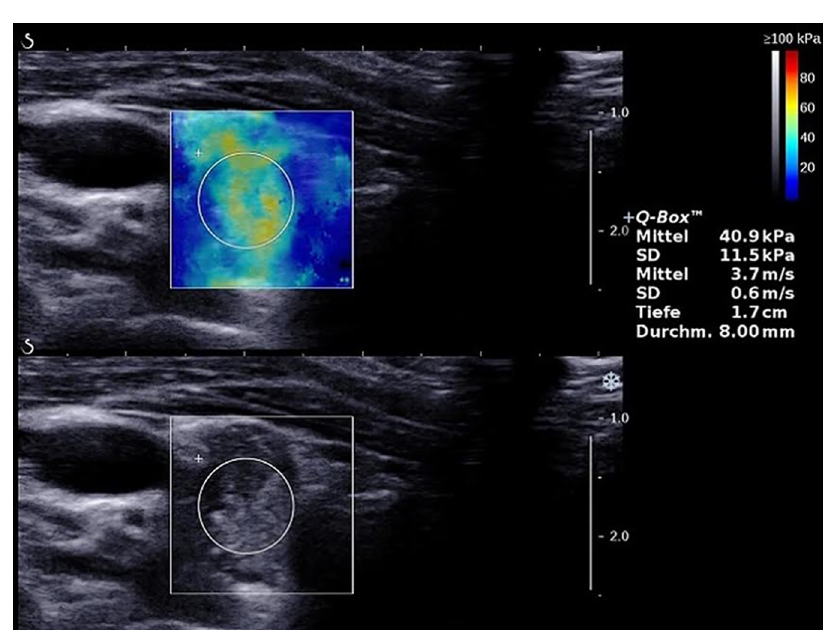
Fig 3. 2D-SWE with the ROI placed within a thyroid nodule in the right thyroid lobe measuring a velocity of 3.7 m/s. Histology revealed papillary